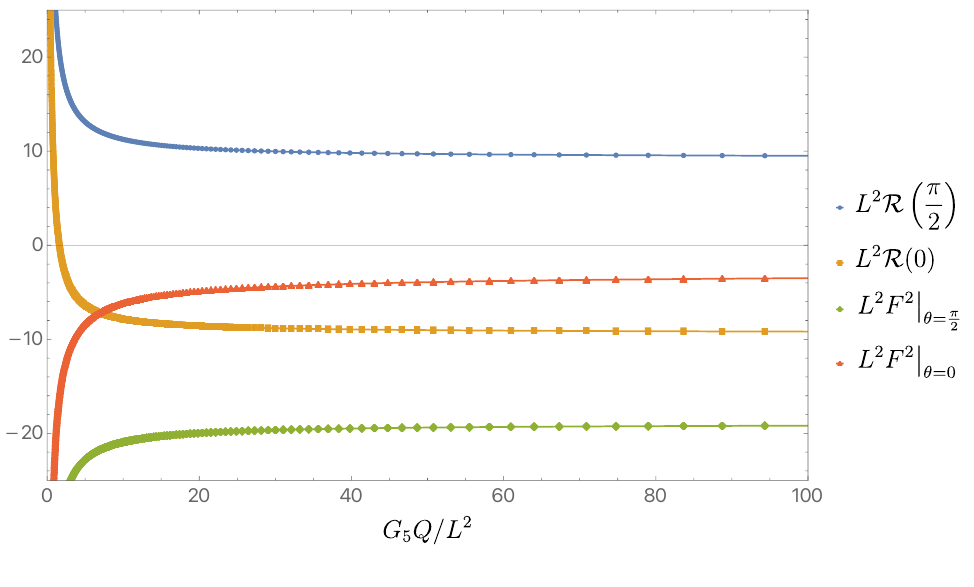
(cid:12) (green diamonds) and F 2 (cid:12) θ = π 2